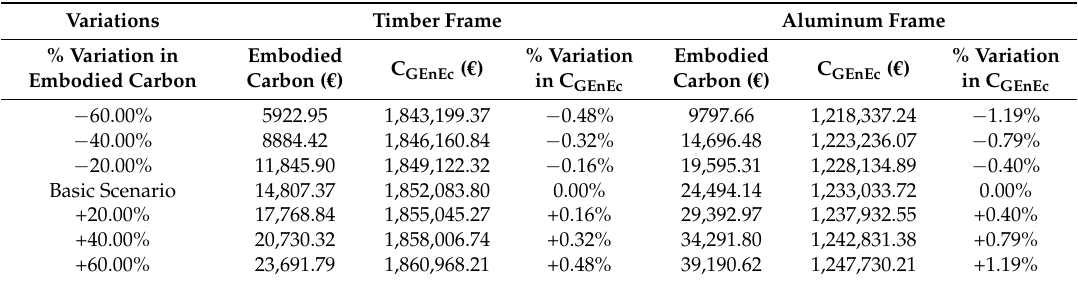
Table 15. Sensitivity analysis with decreased/increased Embodied